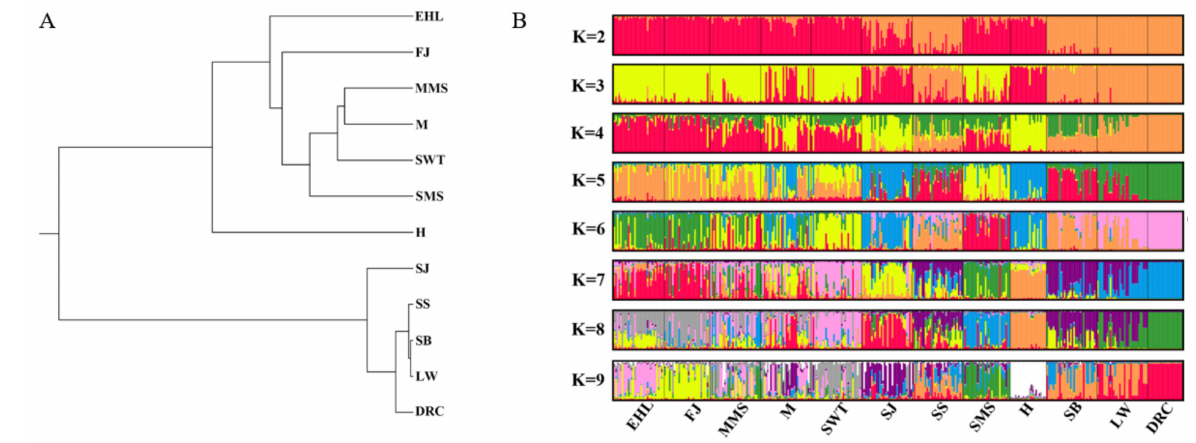
Figure 4. UPGMA tree on Nei’s genetic distances and graphical representation with K 2–9. ( A ) UP- GMA tree constructing by Mega7; ( B ) graphical representation with K 2–9 by STRUCTURE software. Different color showed different origination. EHL, Erhualian; FJ, Fengjing; MMS, Middle Meishan; M, Mi; SWT, Shawutou; SJ, Sujiang; SS, Sushan; SMS, Small meishan; H, Huai; SB, Sicilian black pig; LW, Large White; DRC, Duroc.